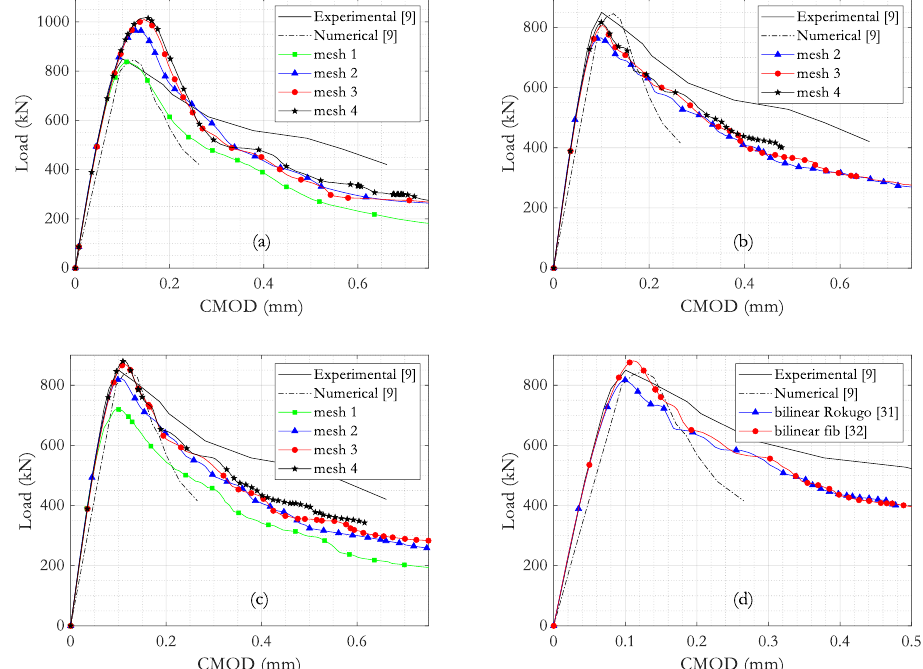
Figure 5. Load versus CMOD results for: ( a ) linear softening; bilinear softening using ( b ) Rokugo et al. [31] and ( c ) fib model code 2010 [32]; ( d ) comparison of bilinear model results for mesh 4.